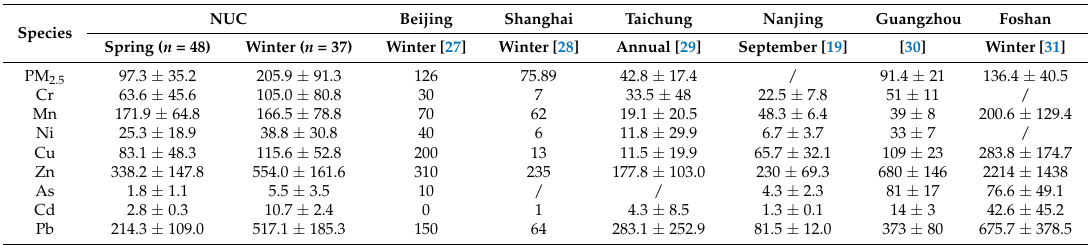
Table 3. The average concentrations (mean ± SD) of PM 2.5 ( µ g m -3 ) and heavy metals (ng m − 3 ) at NUC and in other cities of China.